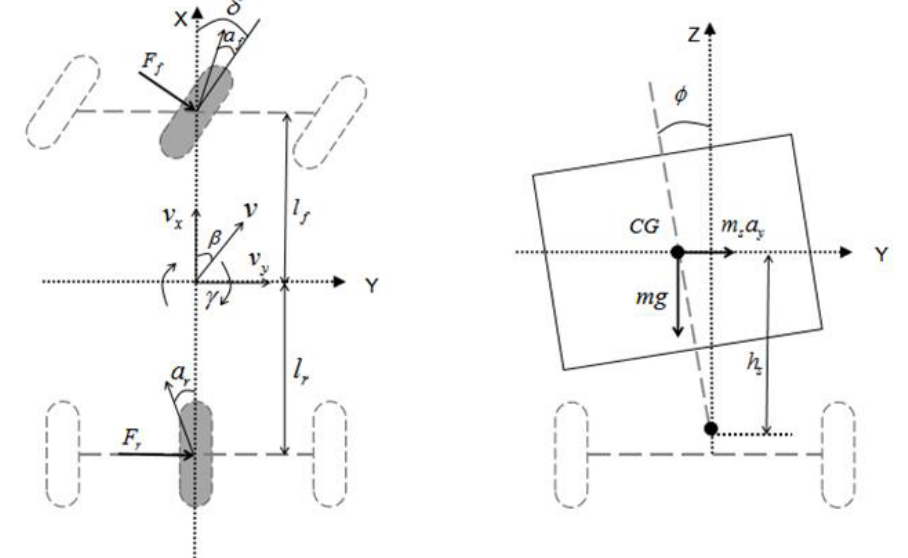
Figure 1. Three-degree-of-freedom rollover dynamics model.